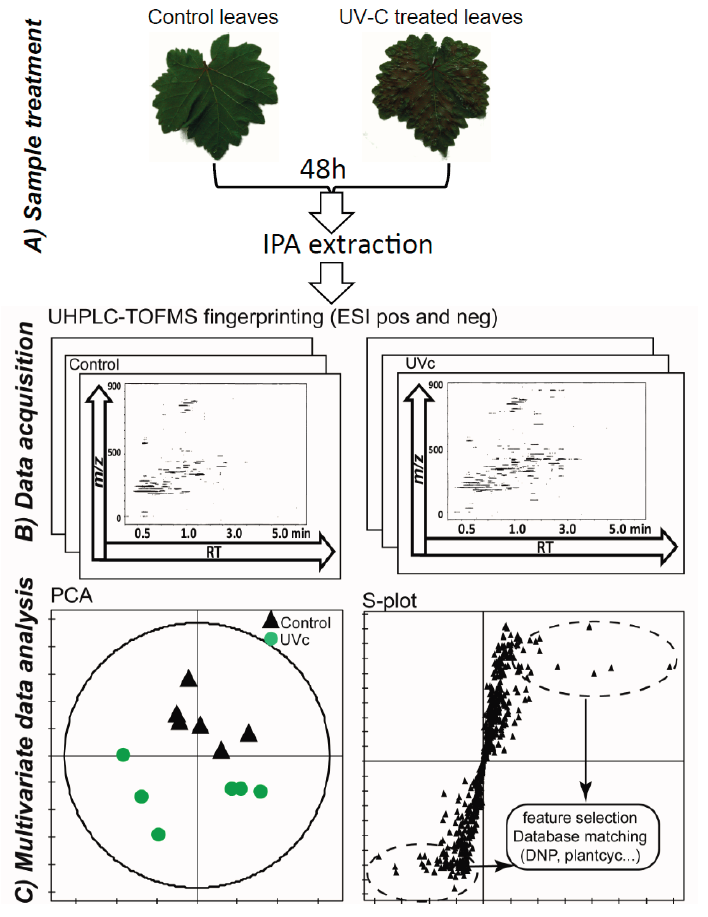
Figure 1. UHPLC-TOFMS metabolomics approach: ( A ) Leaves from independent plantlets were irradiated with UV-C and then extracted using IPA (isopropanol) after 48 h. Pictures of Vitis vinifera leaves are displayed. As shown, morphological changes can already be observed after 48 h ( B ) 2D ion maps of NI ESI UHPLC-TOFMS rapid metabolite profiling for each extract; ( C ) Principal component analysis (PCA) of V. vinifera LC-MS data in NI mode and S-plot display after OPLS-DA for the selection of the most important features for further